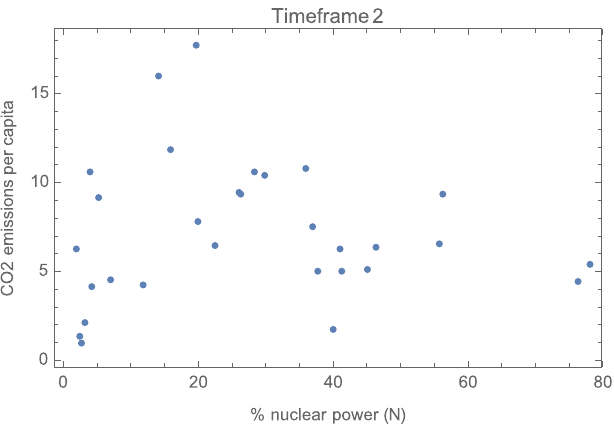
Fig. A.10. CO 2 as a function of N for the nuclear countries in time frame